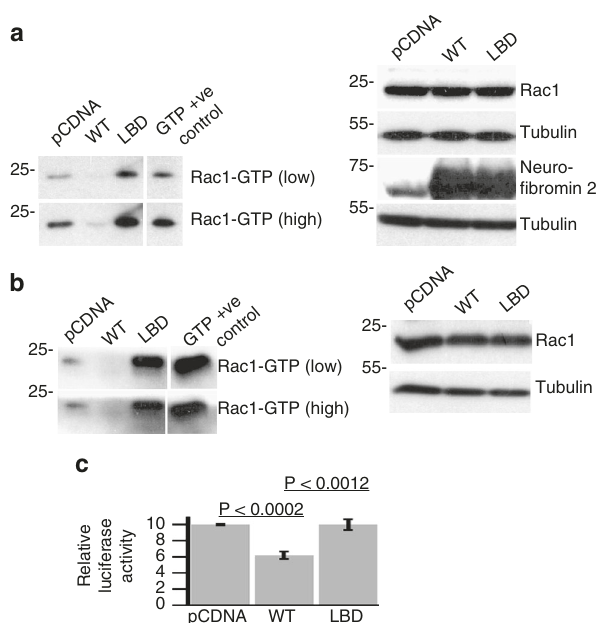
Fig. 5 The lipid binding de fi cient mutant of neuro fi bromin 2 displays impaired inhibition of Rac1 activation and YAP activity. a 293 T or b SC4 cells were transfected with expression vectors for wild type or lipid binding de fi cient neuro fi bromin 2 or empty vector control (pCDNA) and levels of active Rac1 (Rac1-GTP) were assessed after 48 h. Levels of total Rac1, neuro fi bromin 2, and tubulin were assessed as controls. The blots shown are representative of three biological replicates. c HEK293T cells were transfected with expression vectors for wild type or lipid binding de fi cient neuro fi bromin 2 or empty vector control (pCDNA) along with YAP-driven luciferase and Renilla luciferase reporters. Activity of the luciferase reporter was assessed 24 h post transfection. Means of each data point were calculated from three independent biological replicates conducted in triplicate. Error bars represent ±